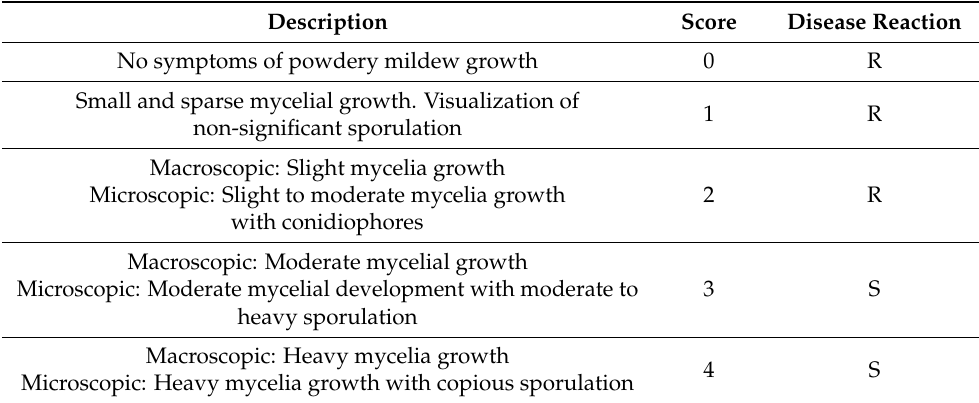
Table 1. Details of the scaling technique adopted for powdery mildew resistance screening in horse gram. Description Score Disease